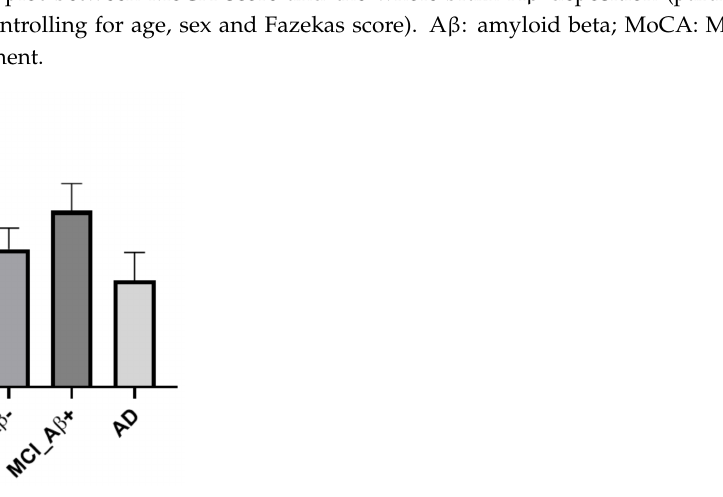
Figure 3. Group comparison of global coupling between structural and functional brain networks (SC-FC coupling) for different cohorts. Note that there was no significant difference between groups ( p -value = 0.16; one-way Brown–Forsythe